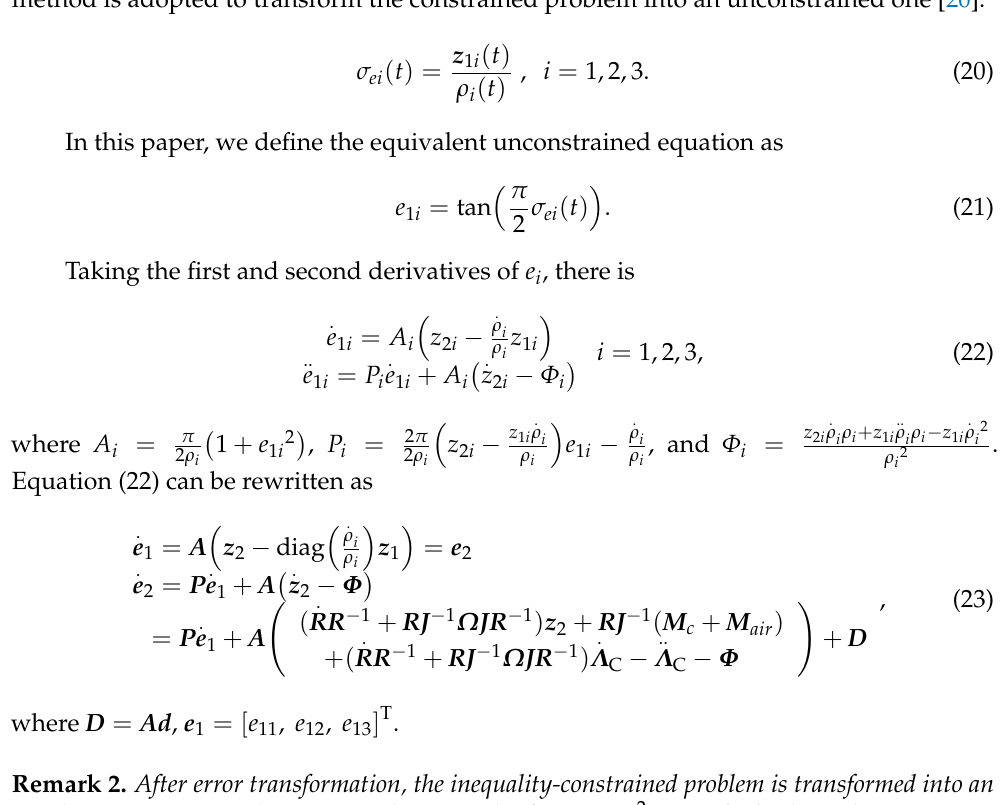
Figure 3. The simulation results of PTPPF: ( a ) the curves of i for five cases; ( b ) the curves of i for five cases.